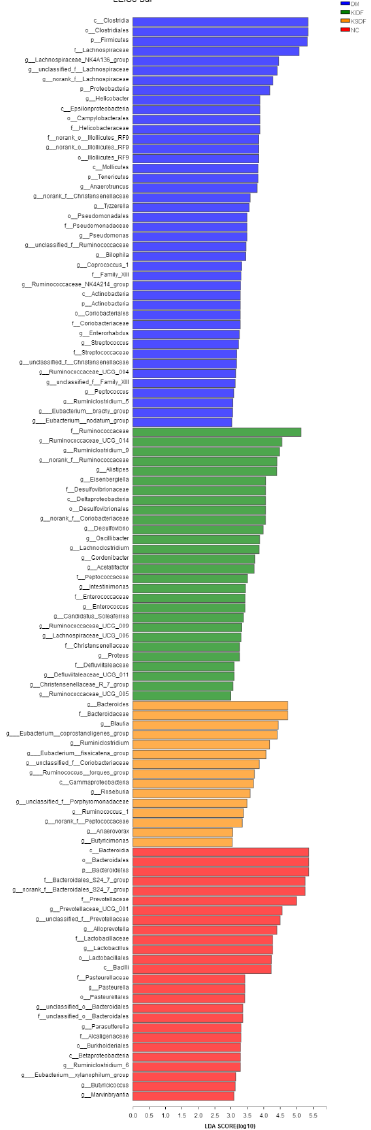
Figure 4. Linear discriminant analysis (LDA) score for taxa differing between the four groups. An LDA score greater than 2 indicated a higher relative abundance in the corresponding group than in the other three groups. Blue bars represent taxa that are significantly increased in the DM group. Green bars represent taxa that are significantly increased in the KIDF group. Orange bars represent taxa that are significantly increased in the KSDF group. Red bars represent taxa that are significantly increased in the NC group.